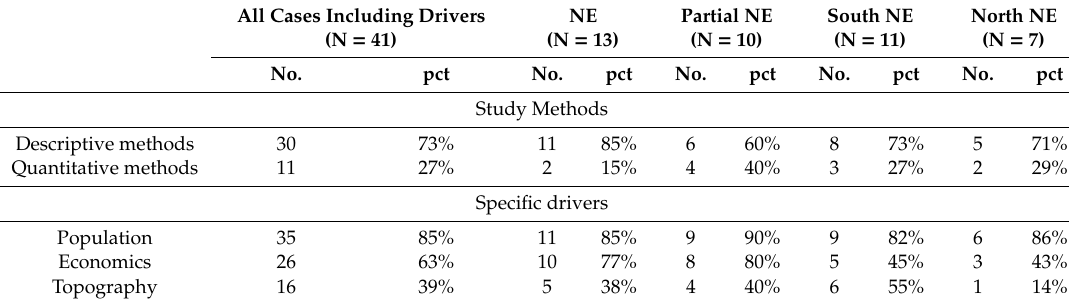
Table 4. Driver study methods and occurrence of specific underlying driving forces in 41